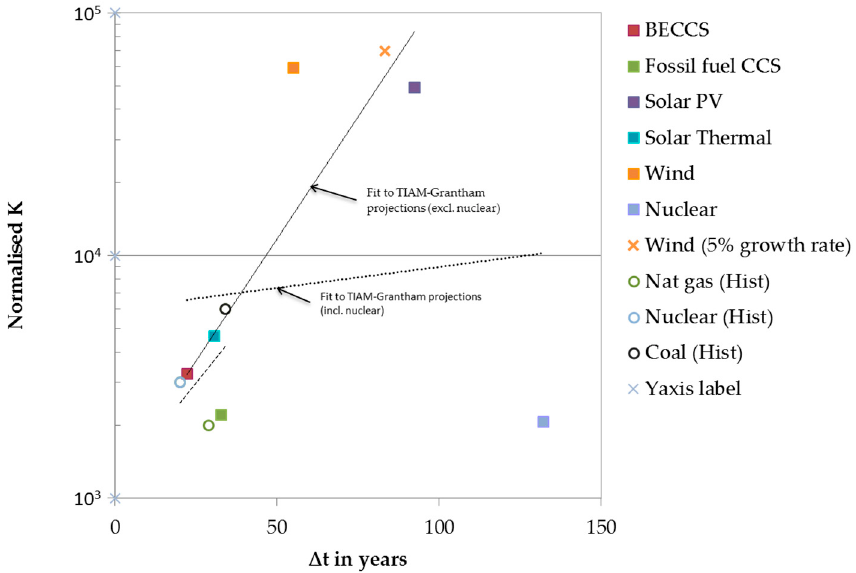
Figure 4. Global extent (Normalised K) vs. duration ( ∆ t) relationship for low-carbon energy technologies from the 2C_Constrained scenario, compared to historical data. Notes: Dotted line represents the fit to the 2C_Constrained TIAM-Grantham projected scenario (including nuclear); solid line represents the fit to the 2C_Constrained TIAM-Grantham projected scenario (excluding nuclear); dashed line represents the fit to historical data (from Wilson et al. [23]). Open circles represent historical data points from Wilson et al. [23]; closed square data points represent 2C_Constrained TIAM-Grantham projected scenario; orange cross is the TIAM-Grantham projection for wind from the 2C_HighlyConstrained